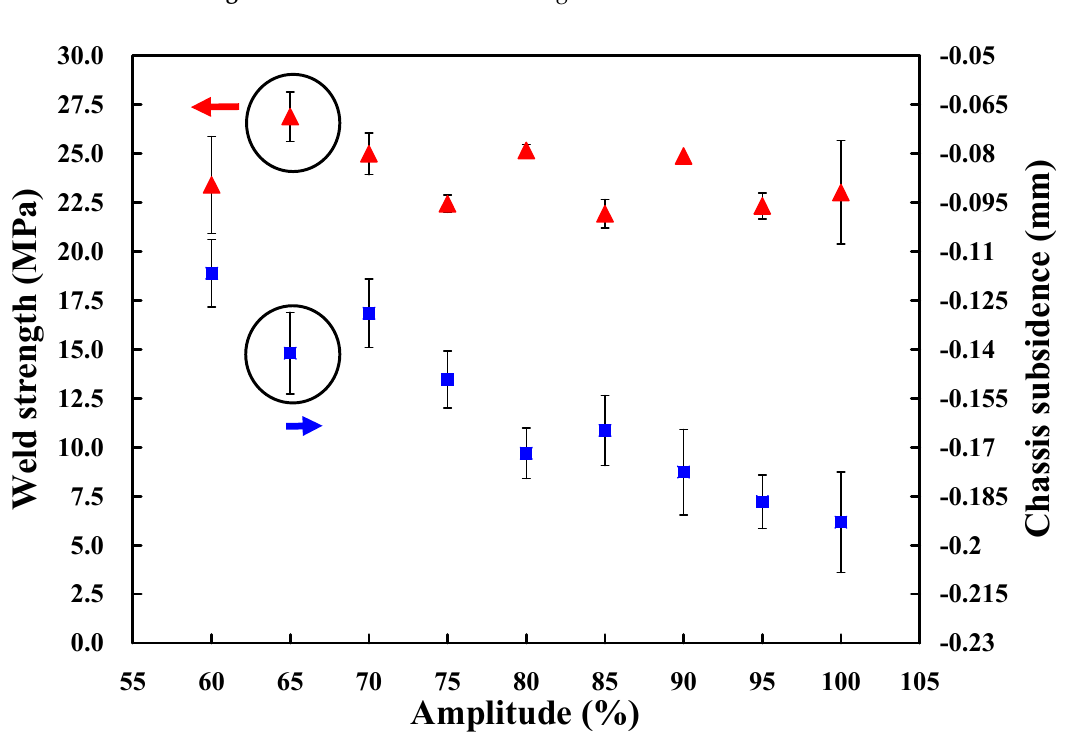
Figure 5. Result of the tensile testing.